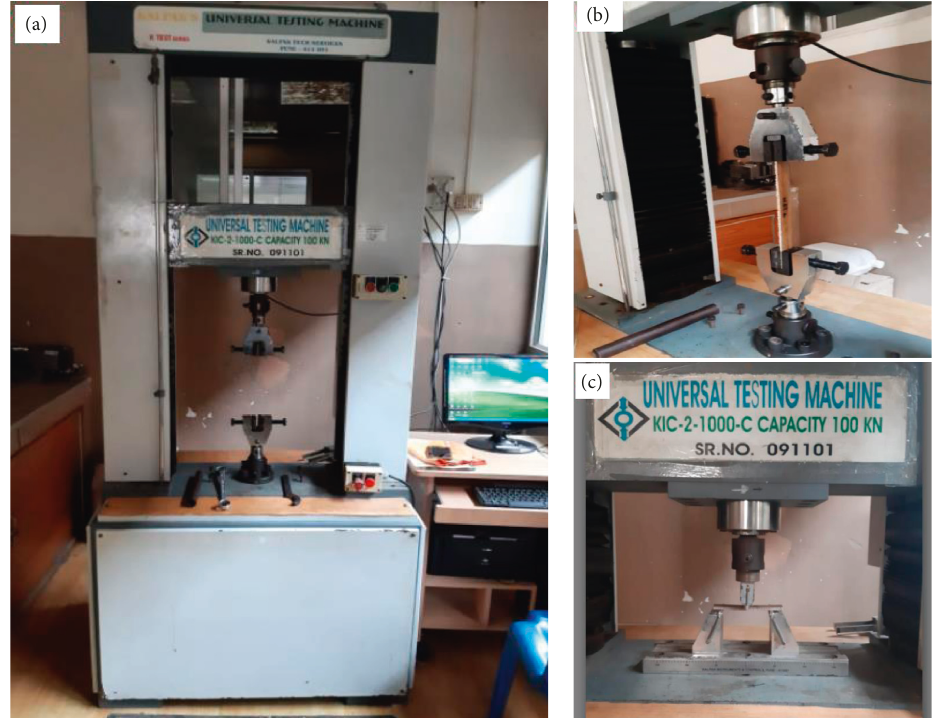
Figure 5: (a) Universal testing machine used for the tensile and flexural test (Make: Kalpak Instruments and Controls, Pune, Model: KIC-2- 1000-C with the capacity of 100kN). (b) Tensile test arrangement. (c) Bending test arrangement.